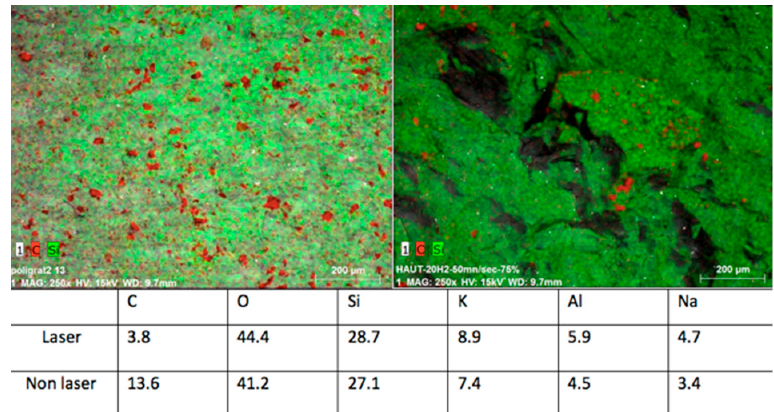
Figure 9. ( Left ) Control group and ( right ) samples irradiated with peak power of 7.5 kW and speed of 50 mm/s: the C concentration is shown in red. Bioengineering 2018 , 5 , x FOR PEER REVIEW